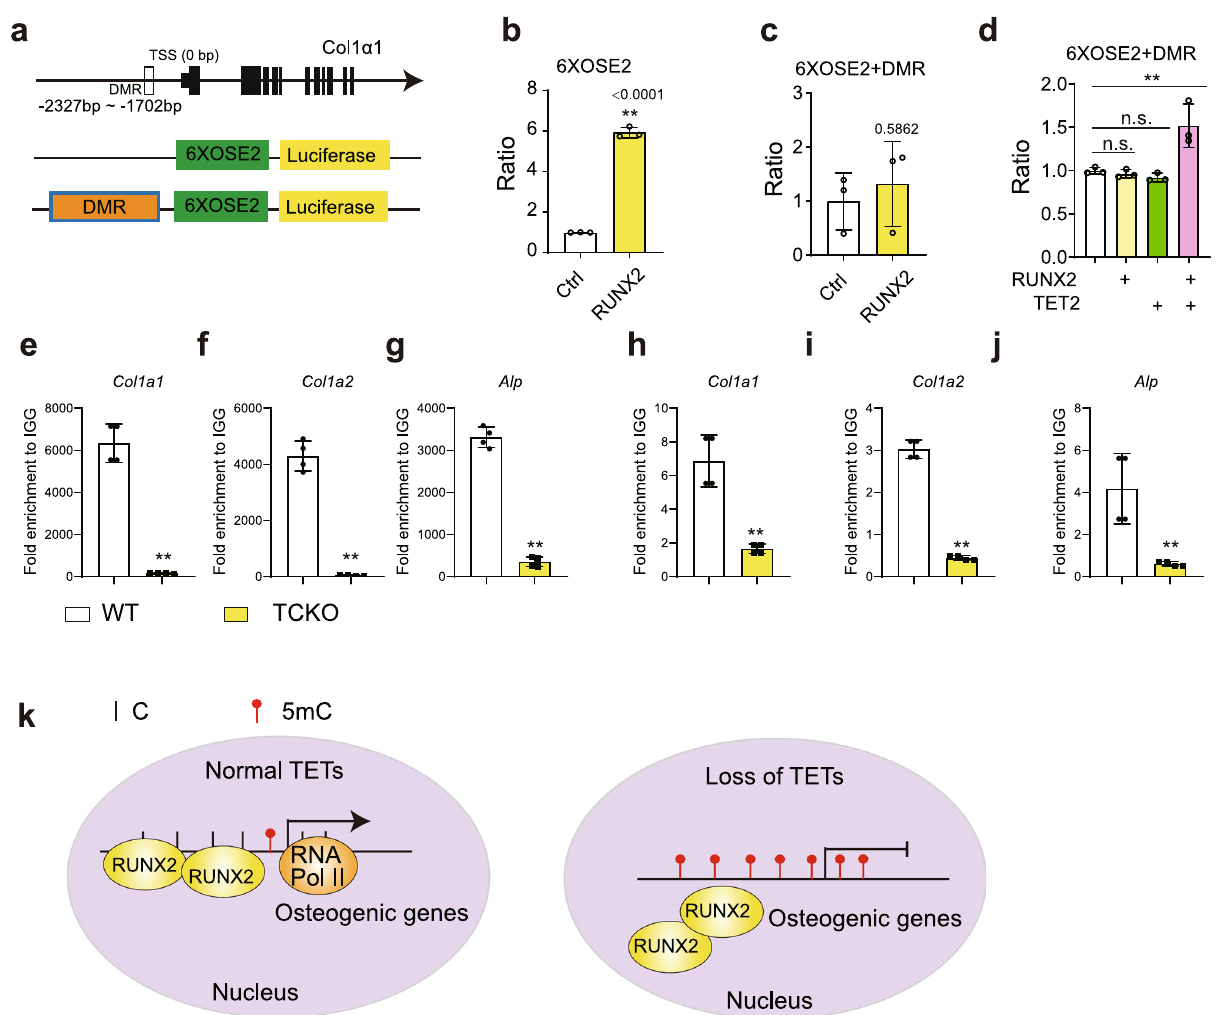
Fig. 7 | RUNX2 recruits TET proteins to the promoter of target genes to facil- itate transcription by modi fi cation of DNA methylation. a The strategy for promoter luciferase assay. OSE2: Osteocalcin-speci fi c element 2. DMR: − 2327bp to − 1702bp of Col1 α 1 promoter. b , c The measurement of luciferase activity for 6XOSE2( b )and6XOSE2+DMR( c )promoterstimulatedbyRUNX2.** P <0.01.Two- tailed Student ’ s t test. Data are presented as mean±s.d., n =3 independent cell samples. d The measurement of luciferase activity for 6XOSE2+DMR treated with TET2or RUNX2separated orcombined.** P <0.01. Ordinaryone-wayANOVA. Data are presented as mean±s.d., n =3 independent cell samples. e – g ChIP-qPCR